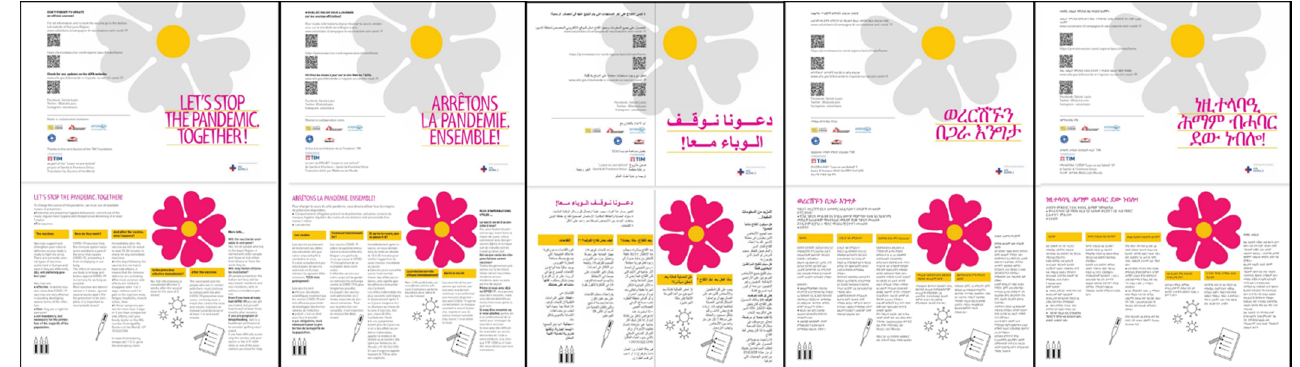
Figure 3. Vaccine information leaflets distributed in the informal settlements. From right to left: English, French, Arabic, Tigrinya, and Amharic. The leaflets were distributed according to the predominant language in the informal settlement. Leaflets in English and French were mainly distributed at the stations, while in the Collatina settlement, the leaflets distributed were mostly in Tigrinya and Amharic.